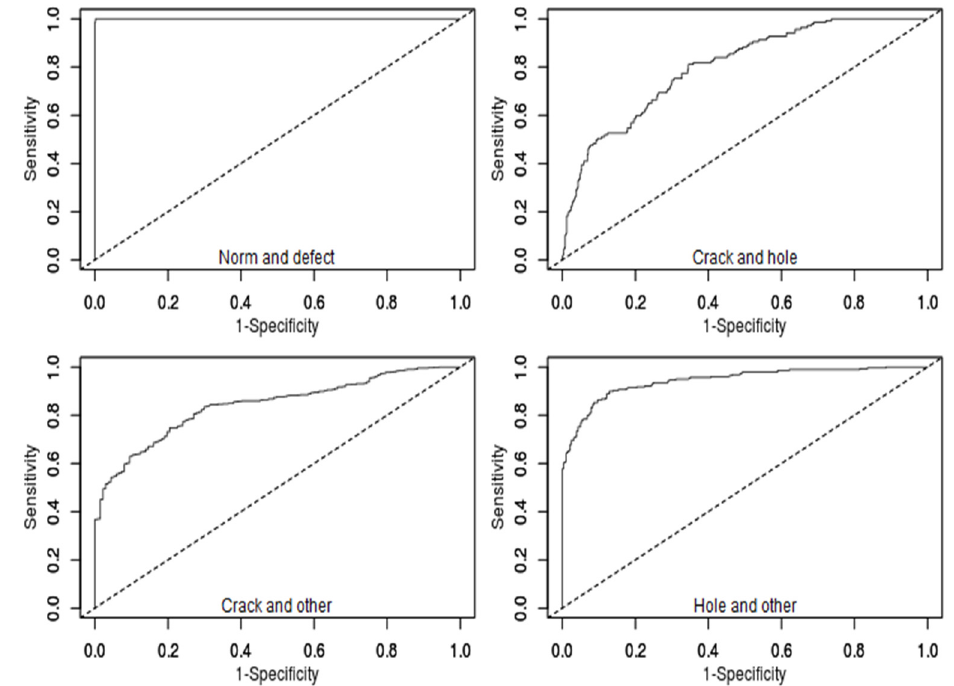
Figure 8. Graphs of Receiver Operating Characteristic (ROC)